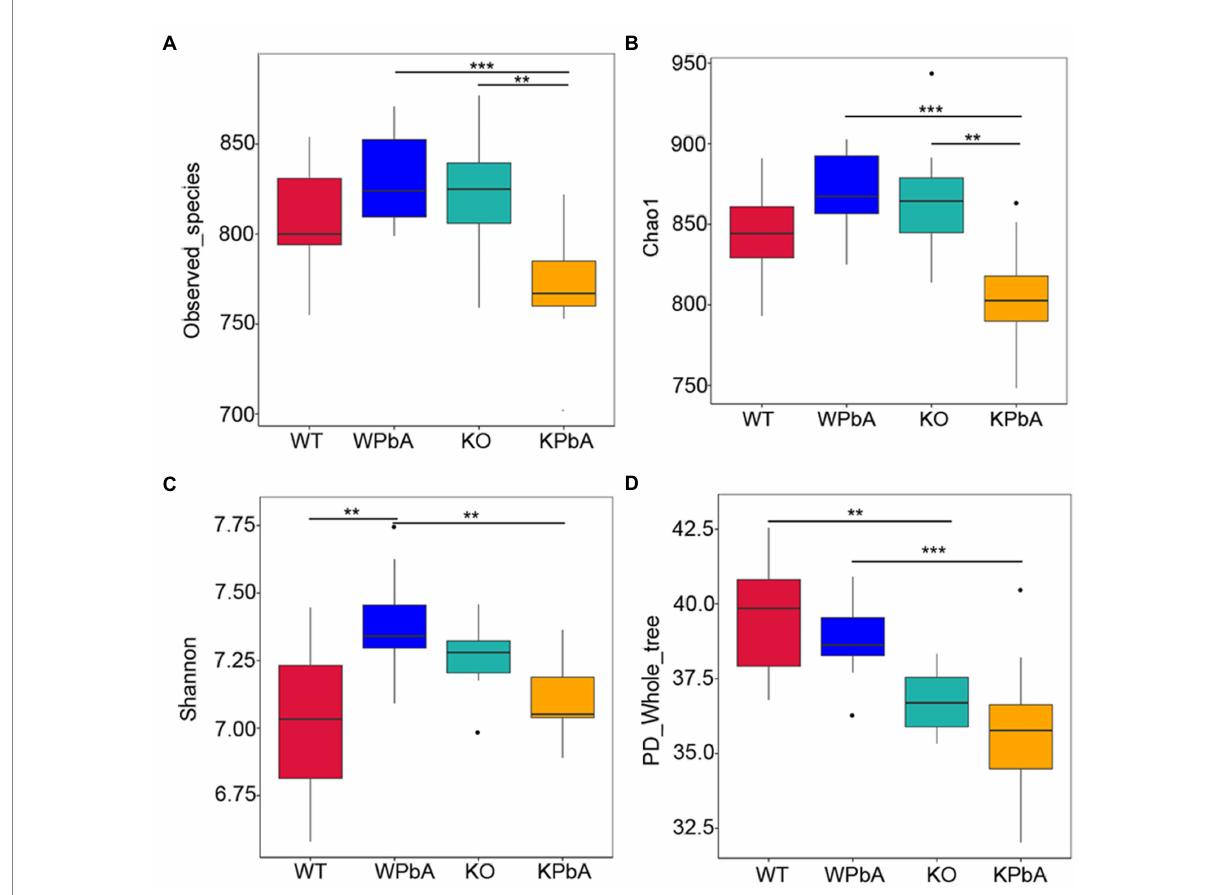
FIGURE 3 The richness and diversity of microbes within communities by alpha analysis. (A) Observed_species, (B) Chao1, (C) Shannon, and (D) PD_whole_ tree. Differences among groups regarding the alpha diversity index were obtained in R software using the Wilcoxon test. Significant differences are indicated via ** p < 0.01 and *** p <